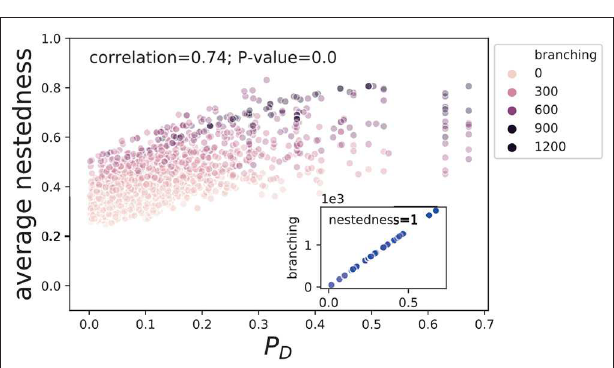
FIGURE 4 | The relationship between average nestedness and P D . P D is the probability of being driving nodes. The definitions of nestedness and branching could be found in section 2.2. The correlations annotated in the plots are for the main axes. The inset illustrates the relationship between P D and branching for stocks with the average nestedness equal to